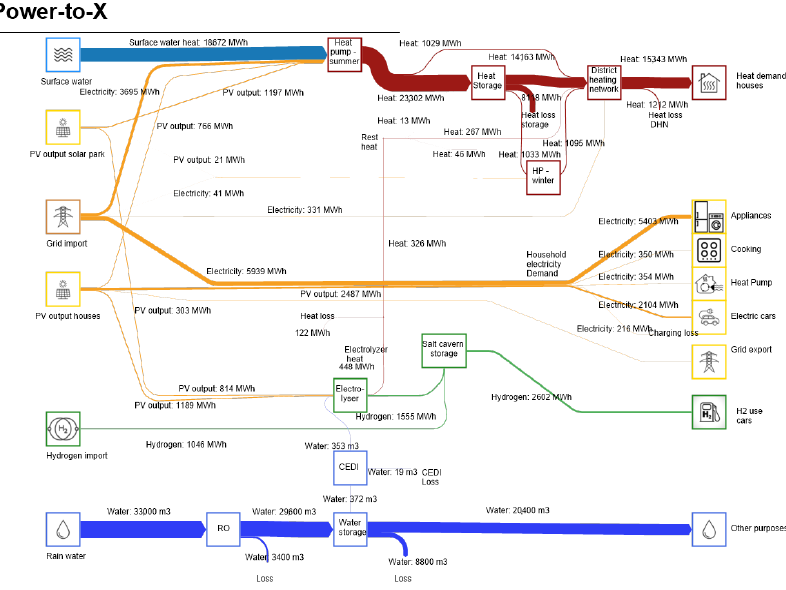
Figure 10. Sankey diagram of the yearly energy and water flows in the power-to-X system. An extra flow is added to the Sankey diagram to show the heat production, storage, and houses' heat demand when a low-temperature district heating system is installed in the neighborhood. The electricity demand of the houses is reduced compared to the other scenarios, as only 354 MWh of electricity is used by the booster heat pumps for tap water production. The district heating network makes a fuel cell for demand peak shaving redundant. The heat pump is shown twice in the Sankey diagram, although only one large-scale heat pump is installed. This large-scale heat pump is used in summer to produce heat (Heat pump summer) and partly in winter as well (HP-winter) to increase the temperature of the heat storage system to a sufficient